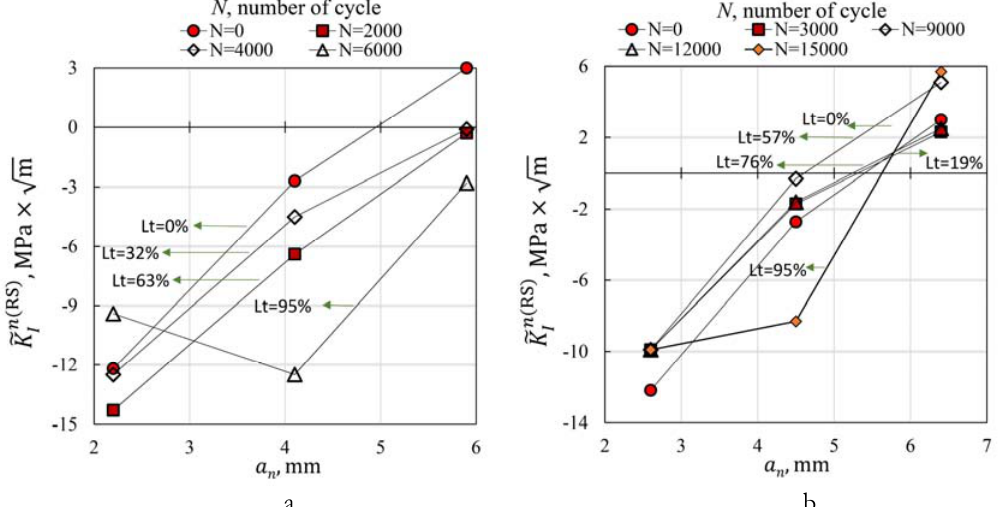
  n RS K values as a function of notches length  I